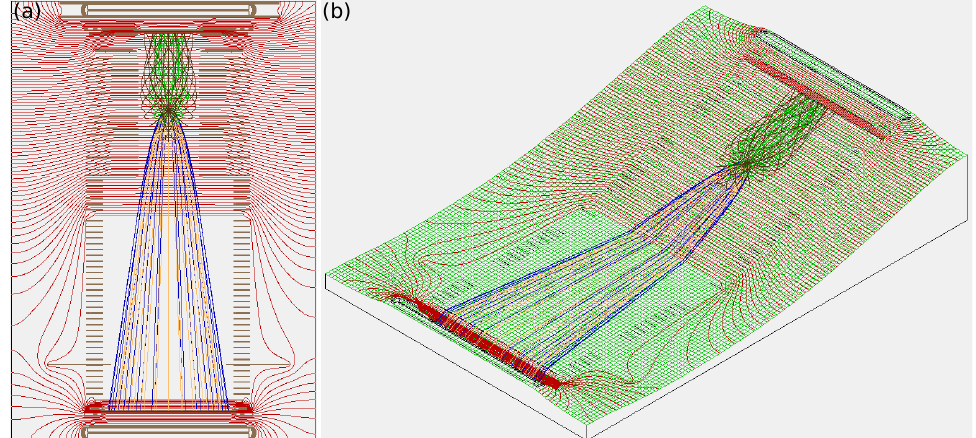
Figure 14. Trajectory simulation for electron-ion coincidence experiments, with electrons detected by the detector equipped to the short arm, and ions to the long arm. The electric field strength is 47 V/cm, and the magnetic flux density is 14.5 Gauss. The trajectories of electrons with kinetic energies of 65 eV and 130 eV are shown in green and brown, respectively. The trajectories of N 2 + with kinetic energy of 15 eV and N 3 + with kinetic energy of 30 eV are shown in orange and blue, respectively. The ejection angles relative to the spectrometer axis range from 0 to 360 degrees. ( a ) Side display of spectrometer equipotential lines (red) and particle trajectories. ( b ) Spectrometer equipotential lines (red) and particle trajectories along the potential energy surface